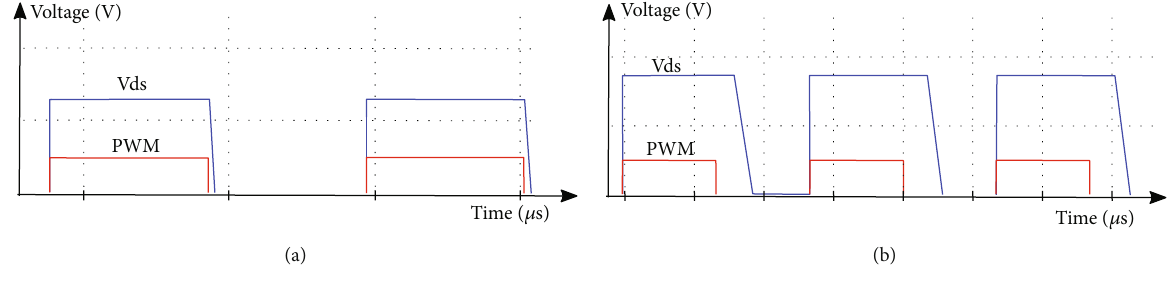
Figure 12: Vds and PWM signals: (a) 23kHz; (b) 186